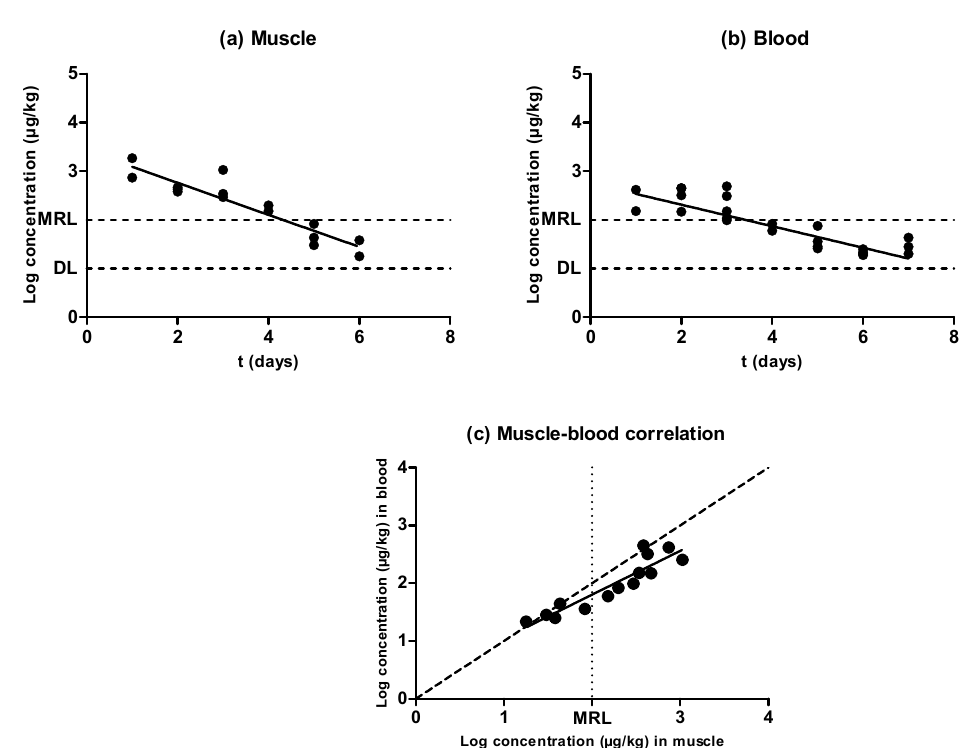
Figure 3. Evolution of the concentration of enrofloxacin in muscle ( a ) and blood ( b ) samples obtained from pigs treated with enrofloxacin and slaughtered at preset intervals within the withdrawal period, determined by LC–MS / MS. The DL dotted line represents the detection limit of the analytical technique for enrofloxacin, and the MRL dotted line represents the maximum residue limit of enrofloxacin in muscle as established by Regulation (EEC) No. 2377 / 90. Relationship among the concentrations of enrofloxacin detected in blood and muscle samples ( c ). The bisecting dotted line represents the 1:1 correlation if both matrixes contained the same concentration of